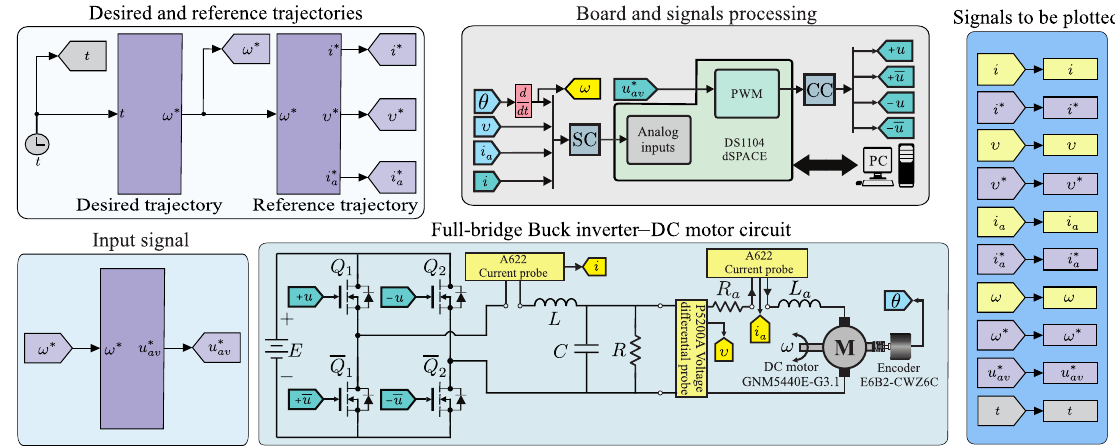
Figure 10. Experimental diagram of the “full-bridge Buck inverter–DC motor” system.